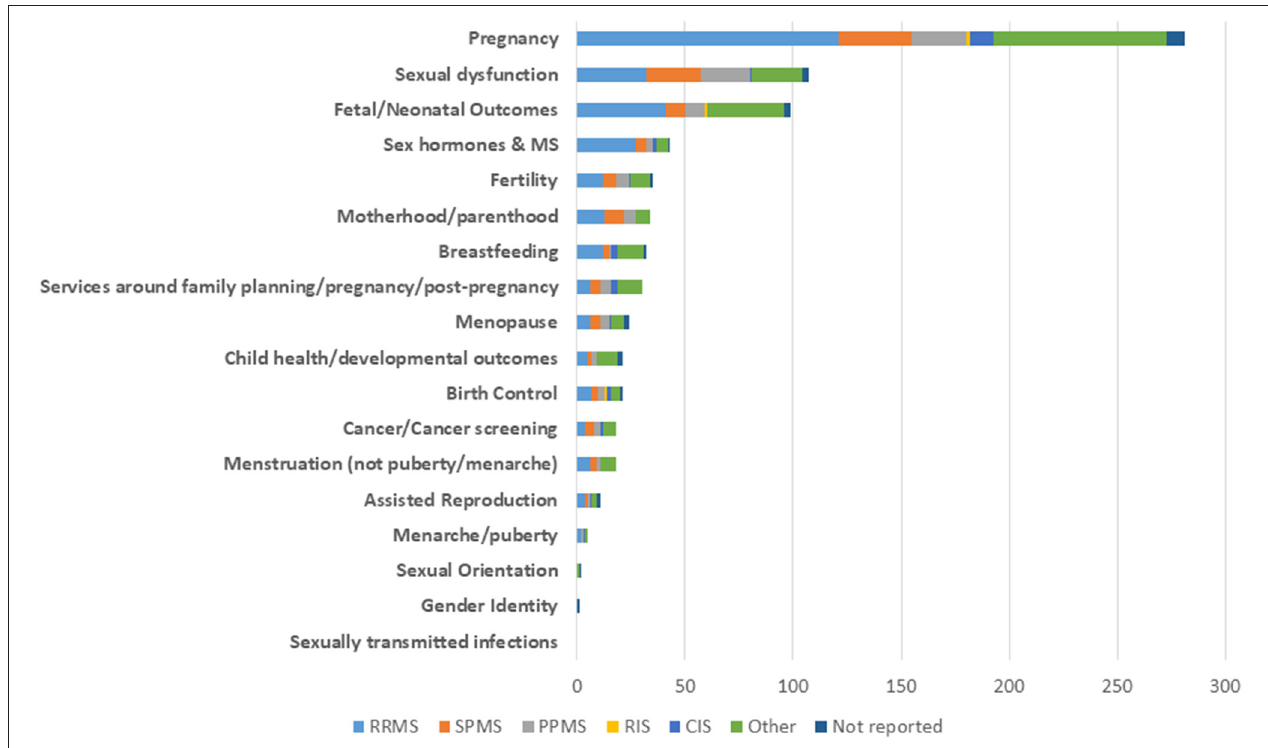
FIGURE 7 | Frequency of study topics according to type of multiple